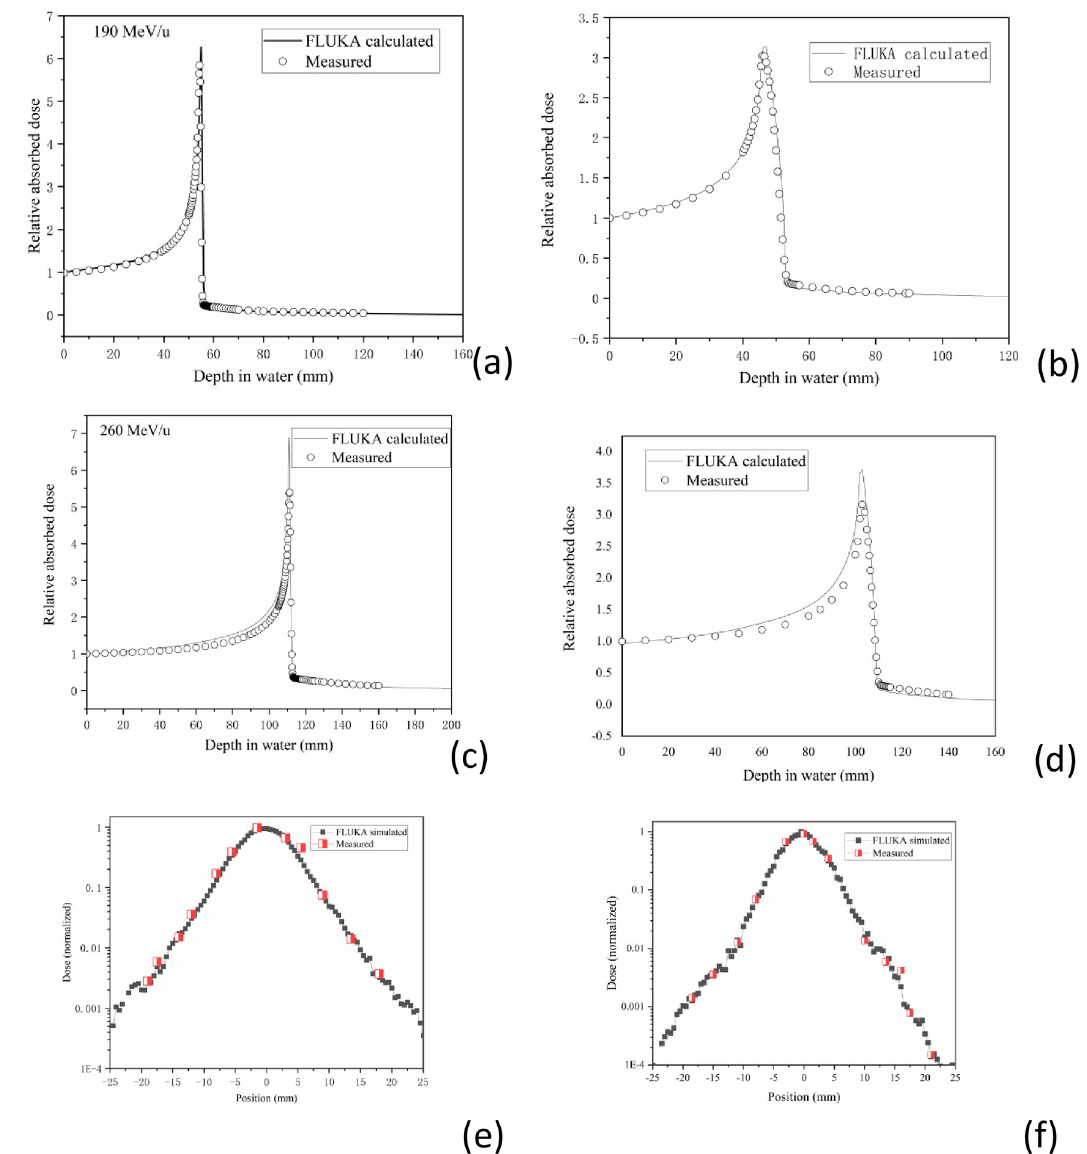
Fig 3. Depth-dose distributions and lateral-dose profiles of carbon ions. MC calculations of laterally IDDDs in water (solid line) in comparison to measured data (open circles) for carbon ions at 190 MeV/u ((a) w/o ripple filter, (b) with ripple filter) and 260 MeV/u carbon ion ((c) w/o ripple filter, (d) with ripple filter). MC simulations of lateral-dose profiles of carbon ions in water, with 190 MeV/u (e) and 260 MeV/u (f) energy, respectively, sampled in before the Bragg peak, in comparison to experimental measurements taken at